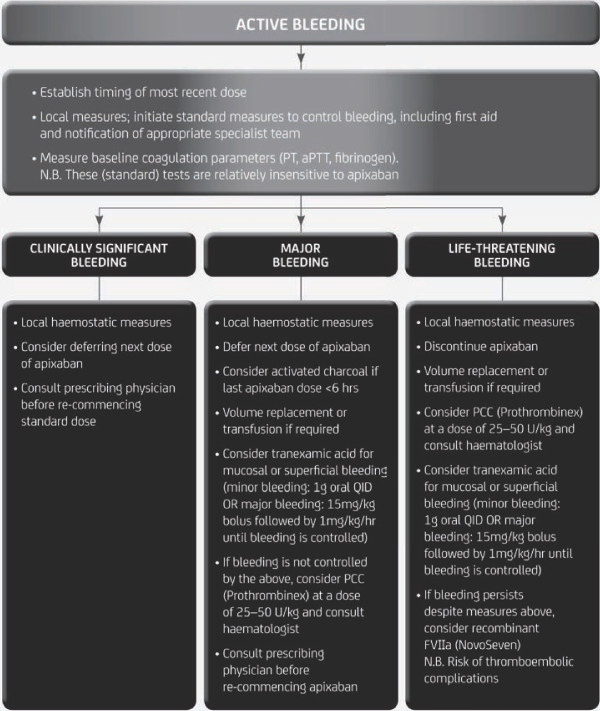
Considerations for the management of bleeding, based on expert consensus.